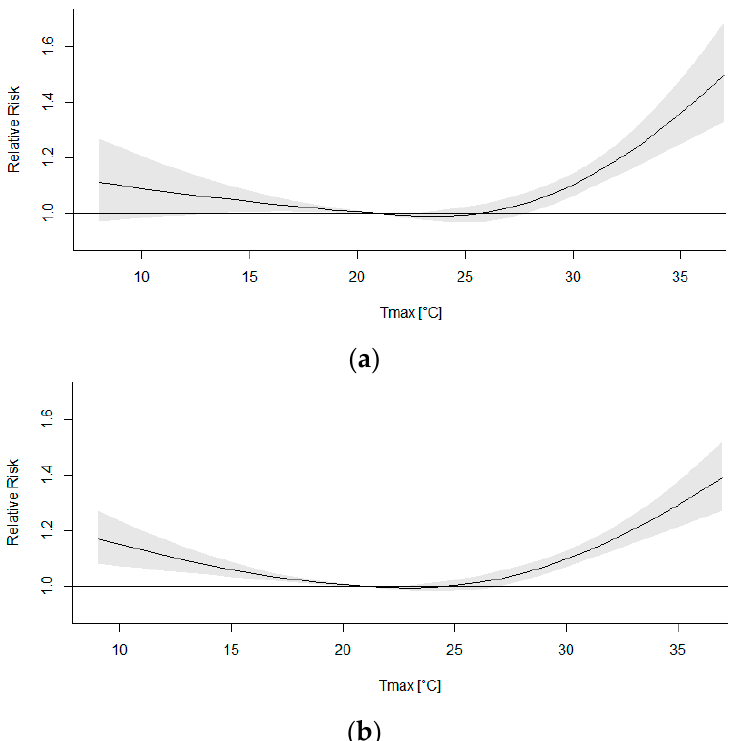
Figure 10. Relation between daily maximum temperature and relative mortality risk (age 65 and older) in warm months (June–September) during 2001–2016: ( a ) Pozna ń ; ( b ) towns with population of below 10 thousand in Wielkopolska.